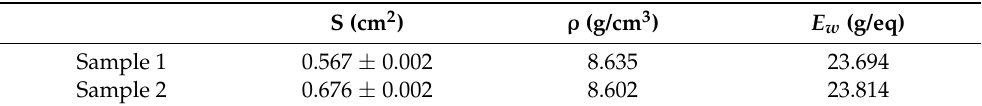
Table 2. Data of surface area, density and equivalent weight of